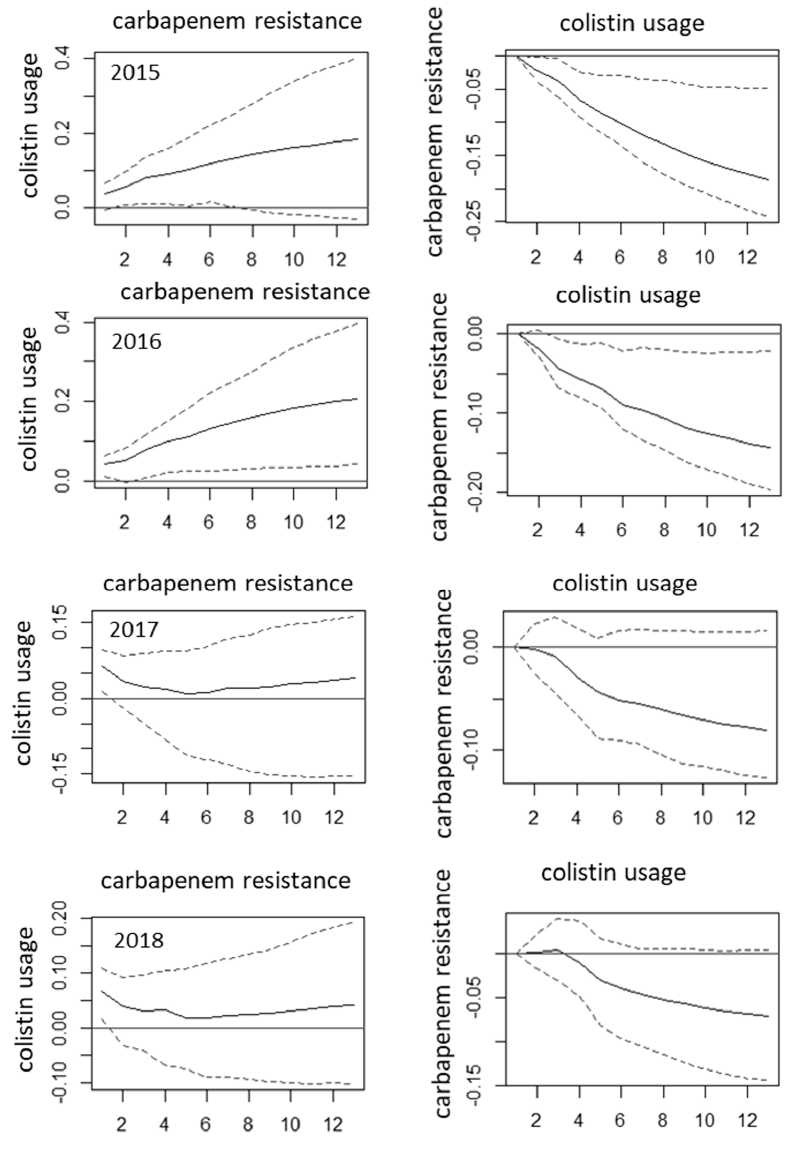
Figure 3. Changes in the relationships between antibiotic use and resistance over time: the example of the relationship between carbapenem resistance in P. aeruginosa and colistin use. Left panel: impulse response functions with incidence densities of infections by carbapenem-resistant P. aeruginosa per 1000 occupied bed-days as impulses and colistin consumption (defined daily doses per 100 occupied bed-days) as responses. Right panel: impulse functions of the reciprocal relationships with colistin use as impulses and incidence densities of carbapenem-resistant P. aeruginosa as responses. Response horizon is shown in the X axis (in months following the impulse), Y axis shows the magnitude of the response. Solid lines are the estimates, dashed lines are the 95% confidence intervals determined by bootstrapping of 100 repetitions. Note that the scales are different. The 2019 results, being similar to 2017 and 2018 results, are not shown due to space